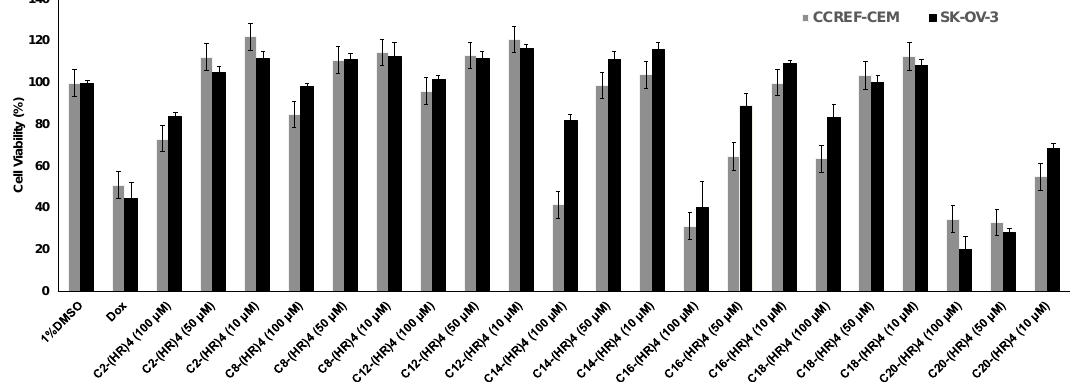
Figure 3. Cytotoxicity study for the fatty acyl-(HR) 4 derivatives at concentrations of 10, 50 and 100 µM after 72 h incubation with CCRF-CEM and SK-OV-3 cells.